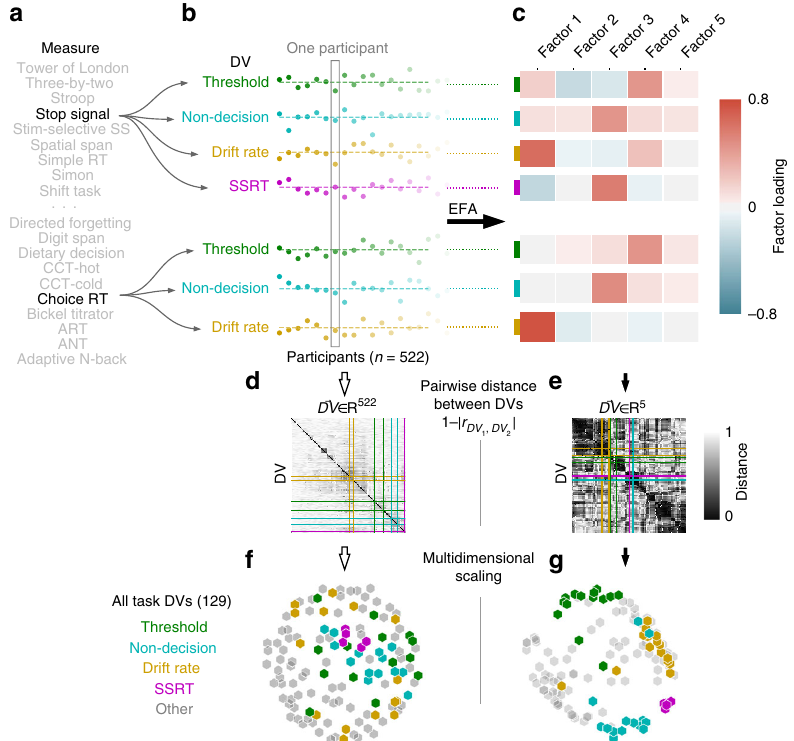
Fig. 1 Summary of Task Analytic Pipeline. a Participants completed 37 separate task measures, of which a subset are shown. b 1st-level analysis of each measure resulted in a number of DVs. Choice Reaction Time and Stop Signal are shown as two example measures, from which 7 DVs are extracted. Participant scores are displayed as deviations from the mean for each of the 7 DVs. A subset of the 522 total participants are shown as individual dots. c EFA projects each DV from a 522-dimensional participant feature space to a lower-dimensional factor feature space. d , e Pairwise-distance between all 129 task DVs are shown for the participant space ( d ) and factor space ( e ). The variables from ( b ) are indicated by colored lines. f , g DV clusters are revealed in the lower-dimensional EFA space. Multidimensional scaling of the pairwise-distances in EFA space ( g , see Methods) highlight obvious clustering, in contrast the participant space ( f ). DVs are colored based on type for visualization purposes only — actual analysis is wholly unsupervised